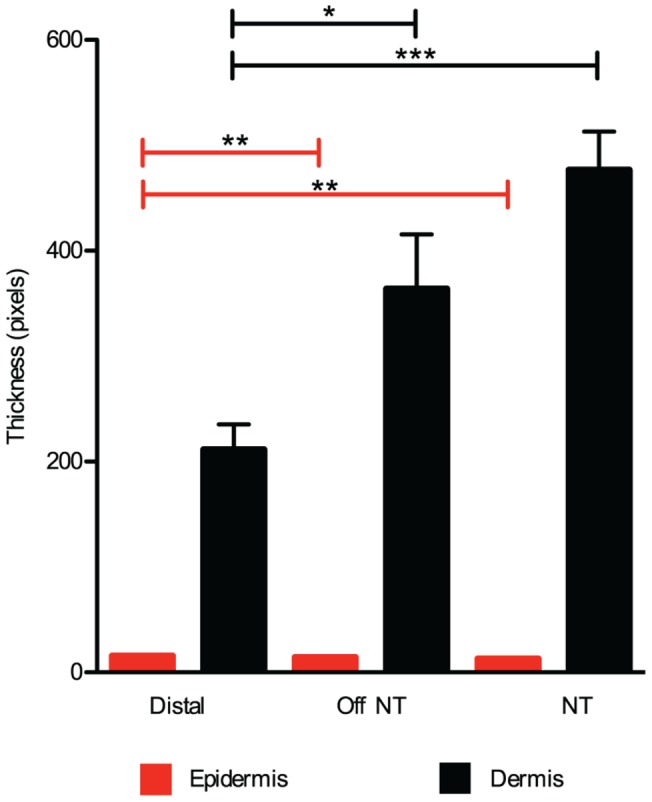
Histomorphometric analysis of epidermal and dermal thickness.Thickness values for epidermis (red) and dermis (black) measured from H&E-stained sections of mouse skin. Specimens were harvested from the hind limb in three areas: distal, proximal off nerve trunk (OffNT) and proximal on nerve trunk (NT). The distal site had a significantly thinner dermis than OffNT and NT (n = 9 sections from three mice per area; *P = 0.016 and ***P<0.0001, respectively; Student's two-tailed unpaired t test). By contrast, distal epidermis was slightly but significantly thicker than OffNT and NT epidermis (**P<0.002).